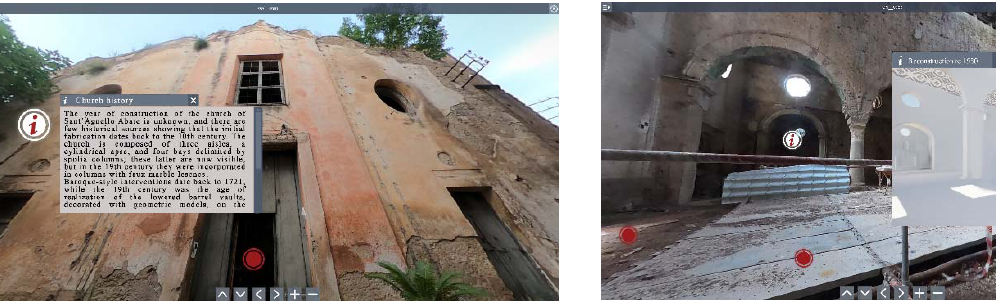
Figures 17-18. Virtual tour navigation with insights on point of